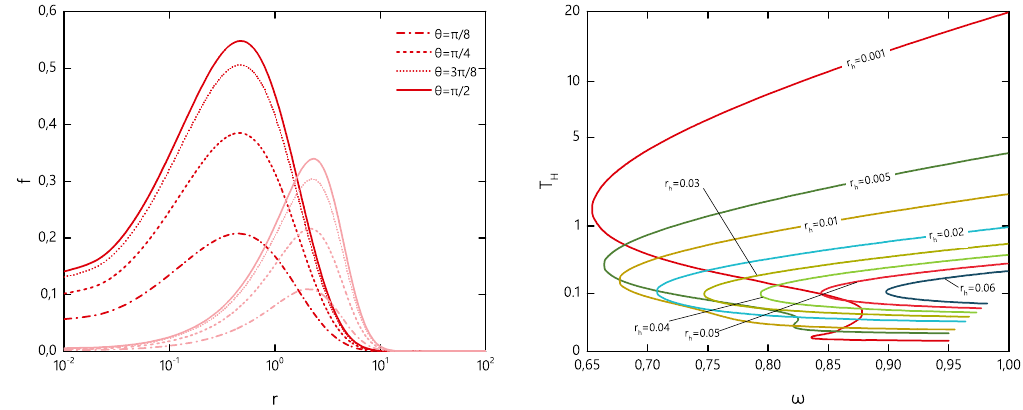
Figure 3 . (Left panel) Scalar (cid:12)eld pro(cid:12)le function f ( r; (cid:18) ) of two hairy BH solutions with r h = 0 : 01 ; w = 0 : 8, one on the (cid:12)rst forward branch (red curves) and another on the second backward branch (blue curves) branches, for several values of (cid:18) = const. (Right panel) Hawking temperature T H of hairy BHs, as function of the angular frequency for a set of values of the horizon radius r h . All solutions have (cid:11) = 0 : 5, m =